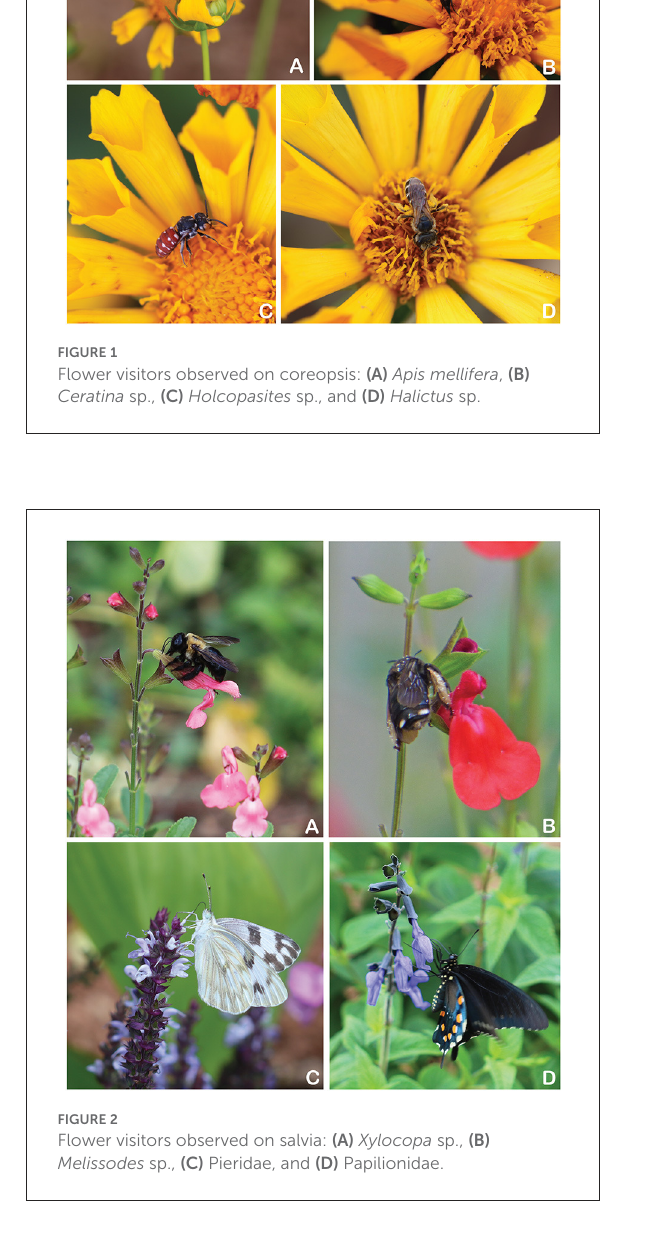
(Spalding Co.; 33 ◦ 24’67”N, 84 ◦ 26’40”W). Cultivar trial plots